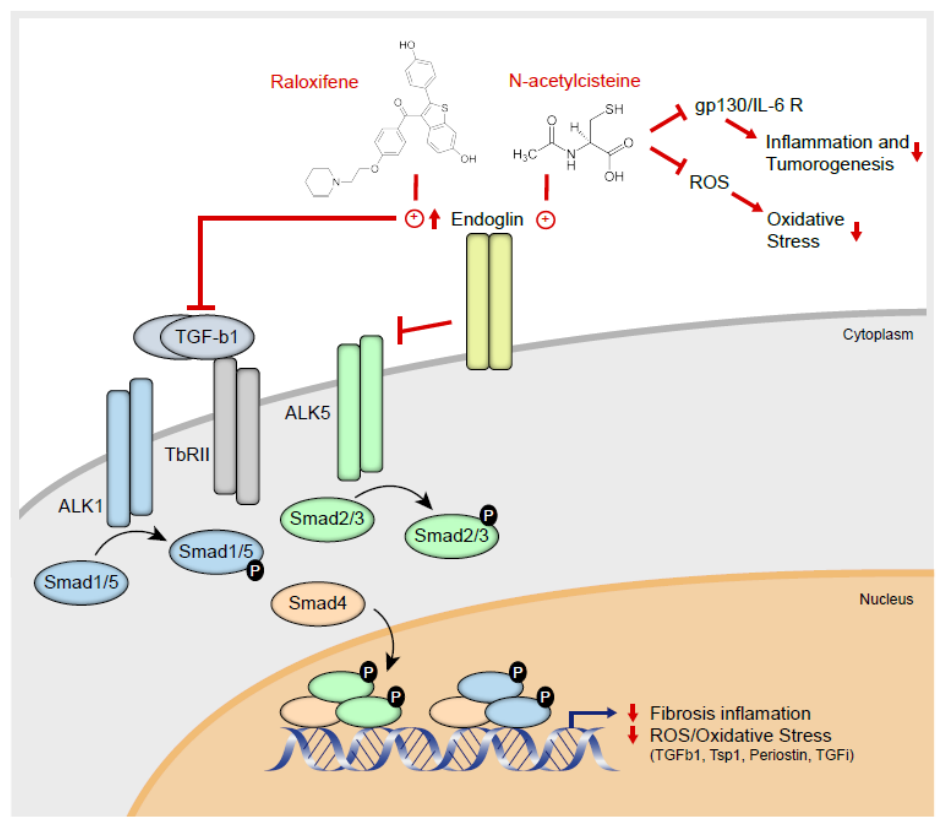
Figure 6. Novel therapies for RDEB based on the dysregulation of upstream extracellular matrix (ECM) mechanisms. Mechanistic mode of action of raloxifene and NAC, activating endoglin and repressing TGF-β1 signaling through the ALK/Smad pathways, thereby dampening fibrosis, inflammation and the effects of reactive oxidative species (ROS). The physiological role of ROS/oxidative stress in RDEB has been defined previously [21].